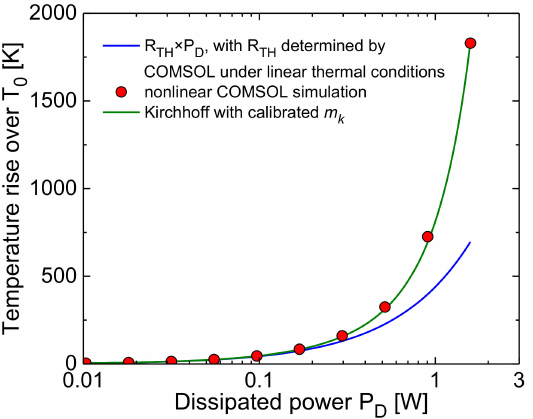
Figure 8. Test device with single unit cell: junction temperature rise over T 0 vs. dissipated power P D , as evaluated by COMSOL under linear (solid blue line) and nonlinear (red symbols) conditions, along with that computed by applying the Kirchhoff’s transformation (10) with calibrated m k = 0.8333 (solid green line) to the linear COMSOL temperature